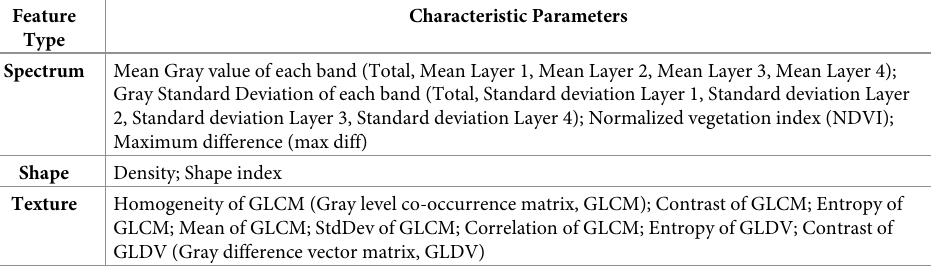
Table 5. Feature